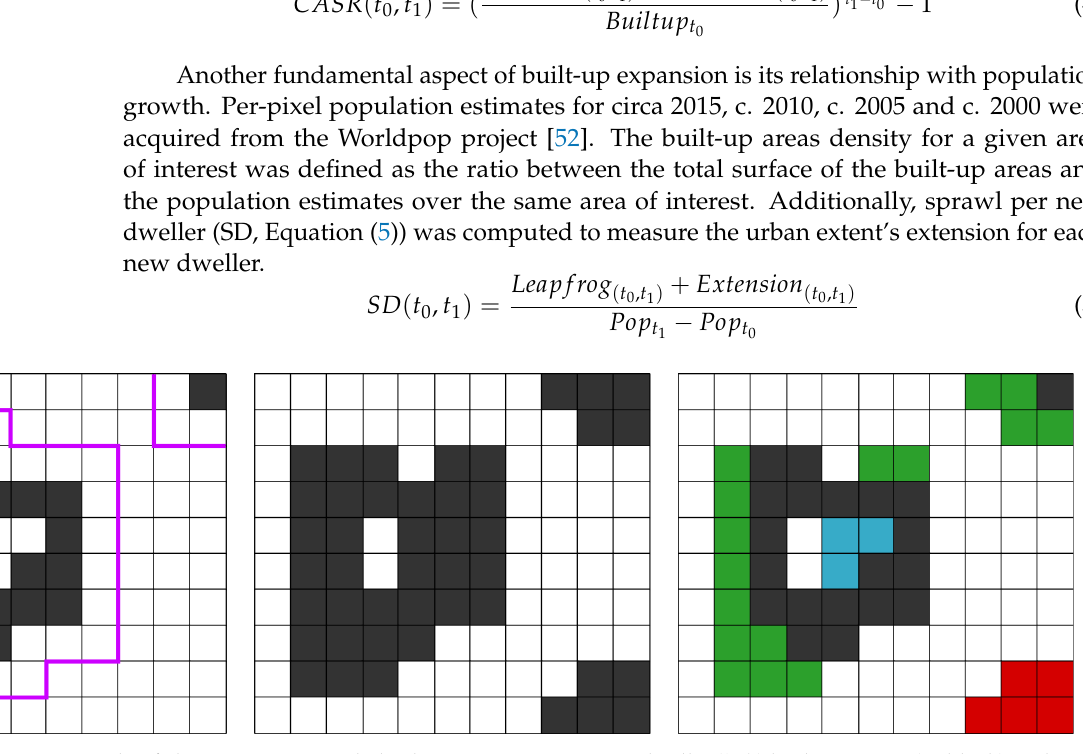
Figure 6. Schematic example of characterizing newly built-up areas in 200 m grid cells: ( left ) built-up areas (in black) and initial urban clusters boundaries (in purple) at t initial , ( middle ) built-up areas at t final , and ( right ) characterized newly built-up areas (existing in black, infill in blue, extension in green, leapfrog in